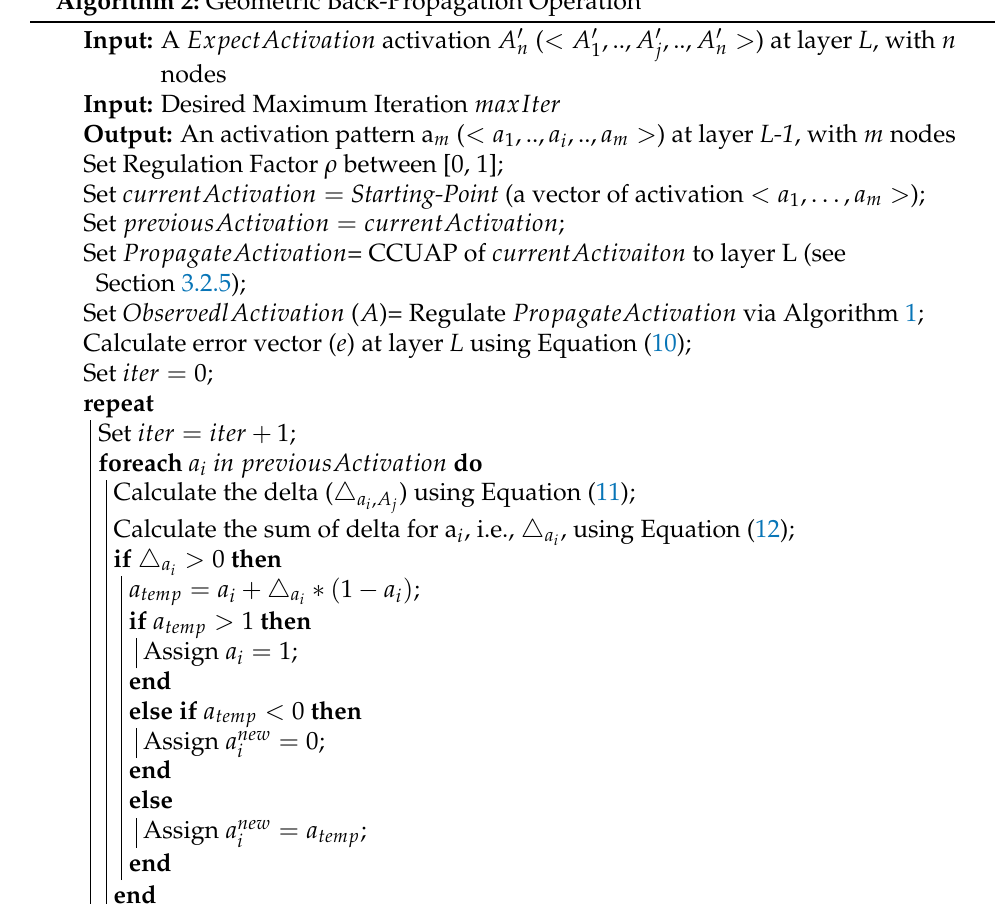
Algorithm 2: Geometric Back-Propagation